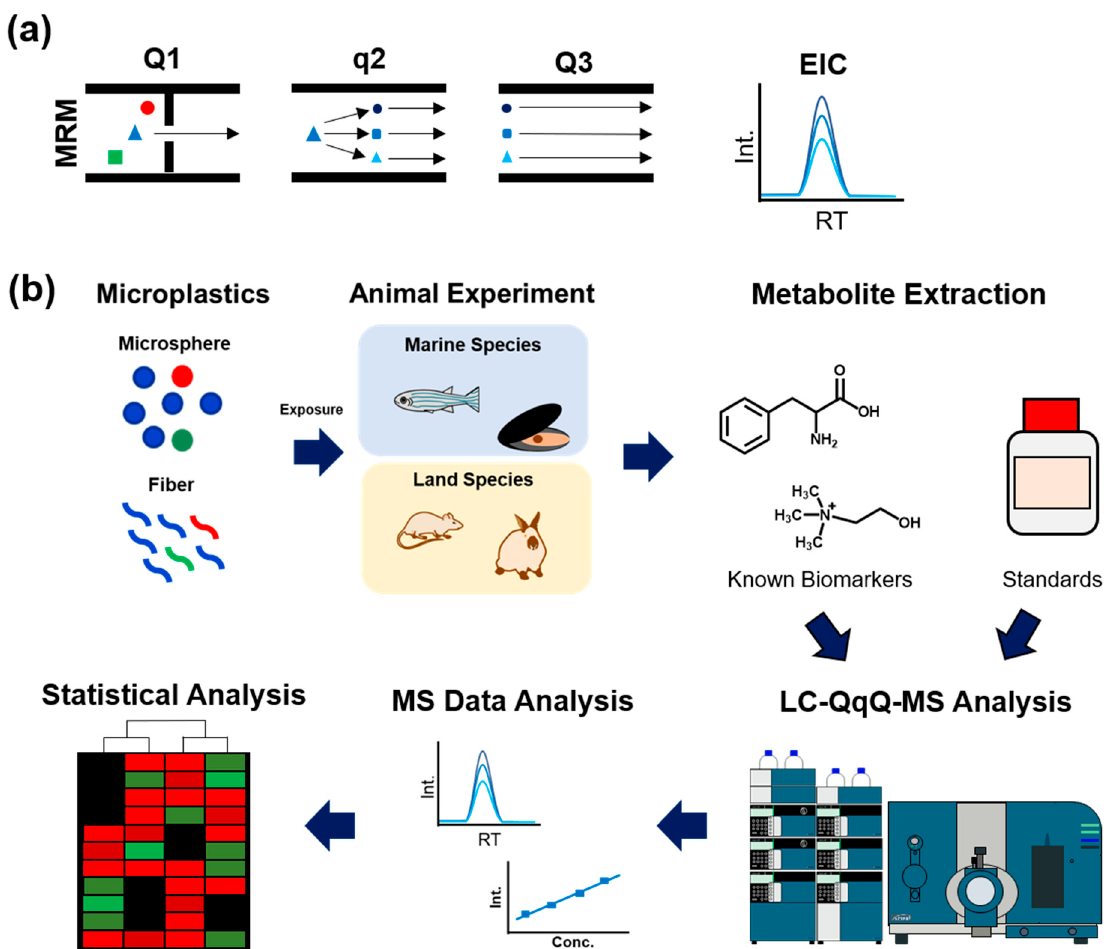
Figure 1. ( a ) Introduction to MRM, the dominant data acquisition mode in targeted metabolomics. ( b ) The general work fl ow of the MPs-induced targeted metabolomics.